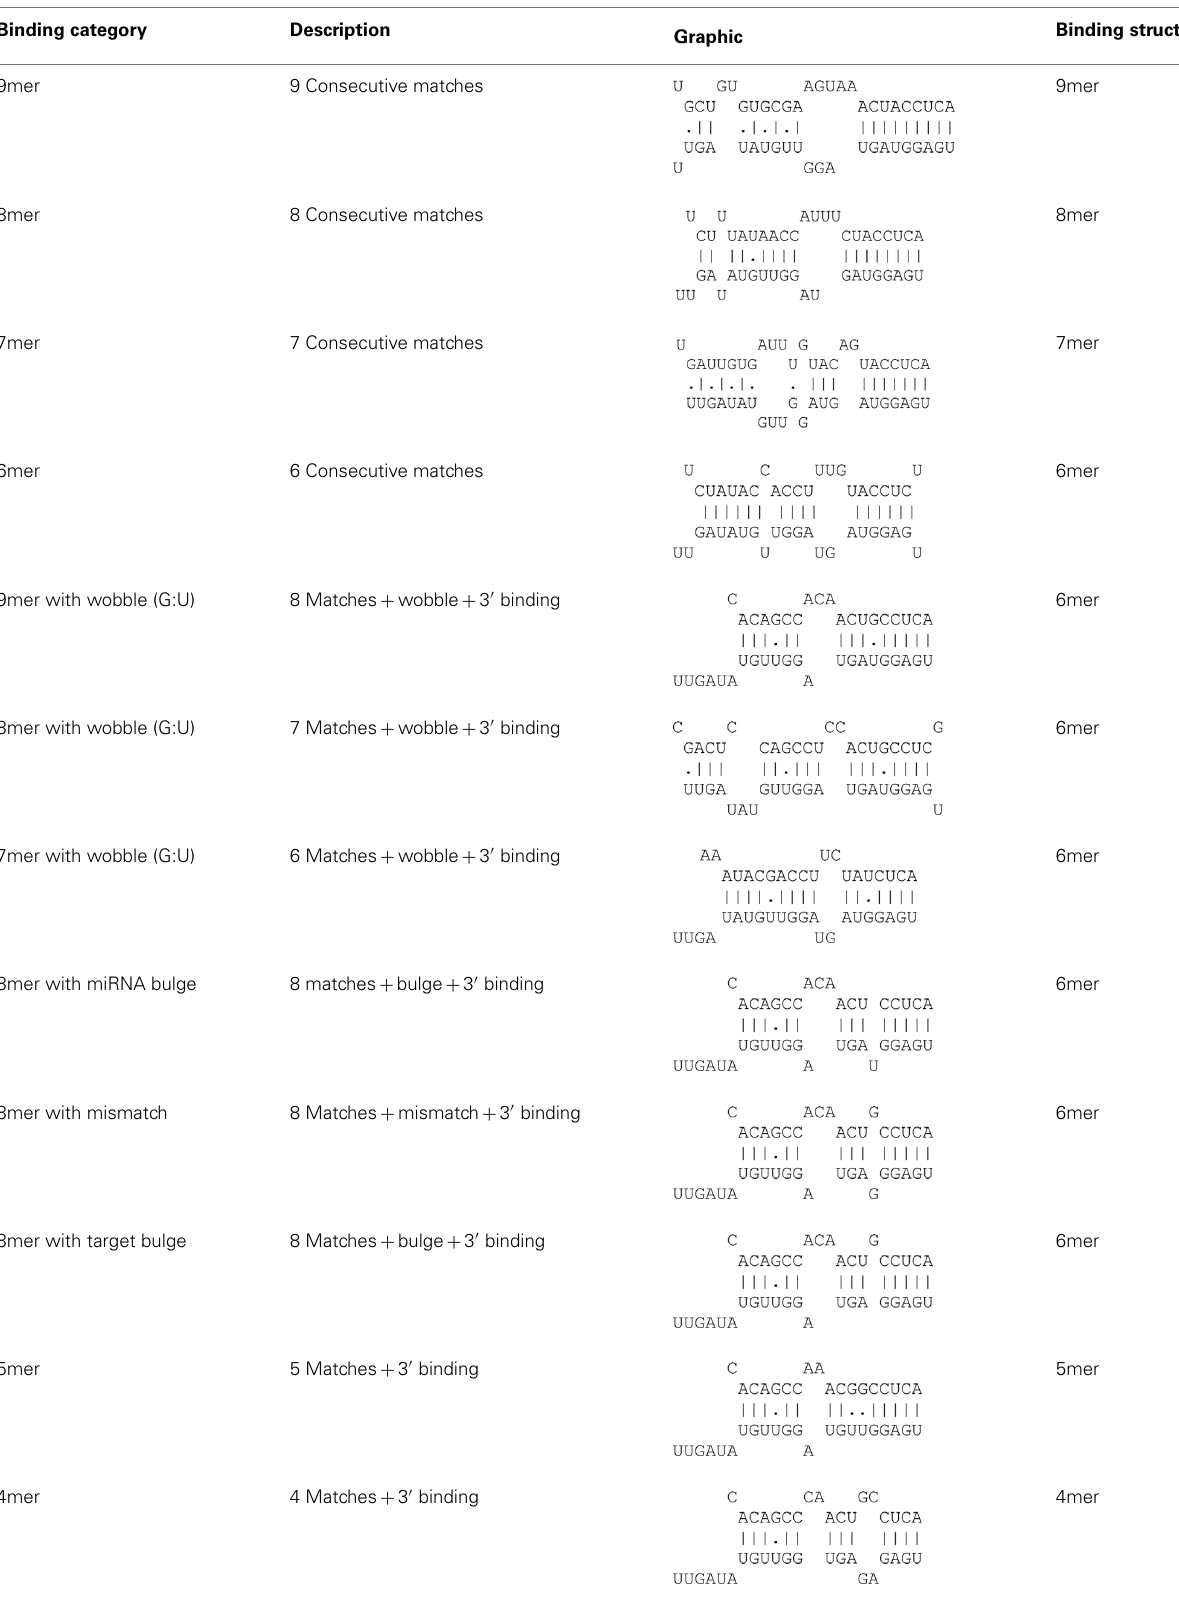
TableA1 | Graphical examples for the allowed binding categories. Binding